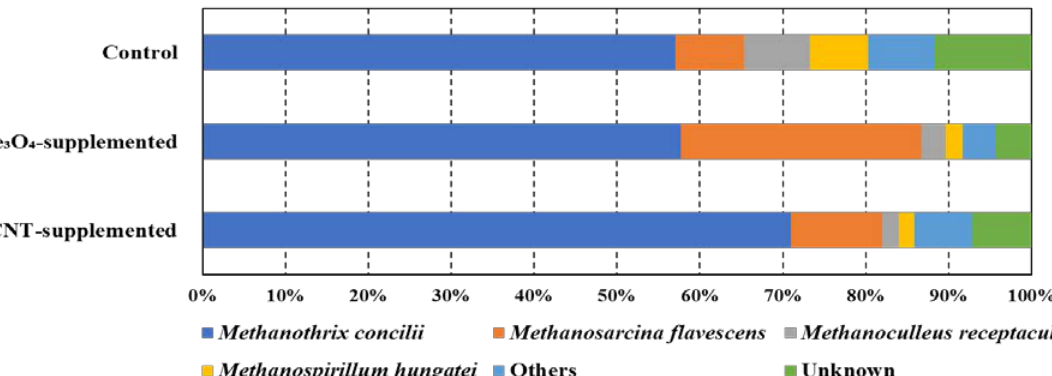
Figure 3. Microbial community structure at genus level for archaea acclimated to oleic acid in control, nFe 3 O 4 -supplemented, and CNT-supplemented batches.